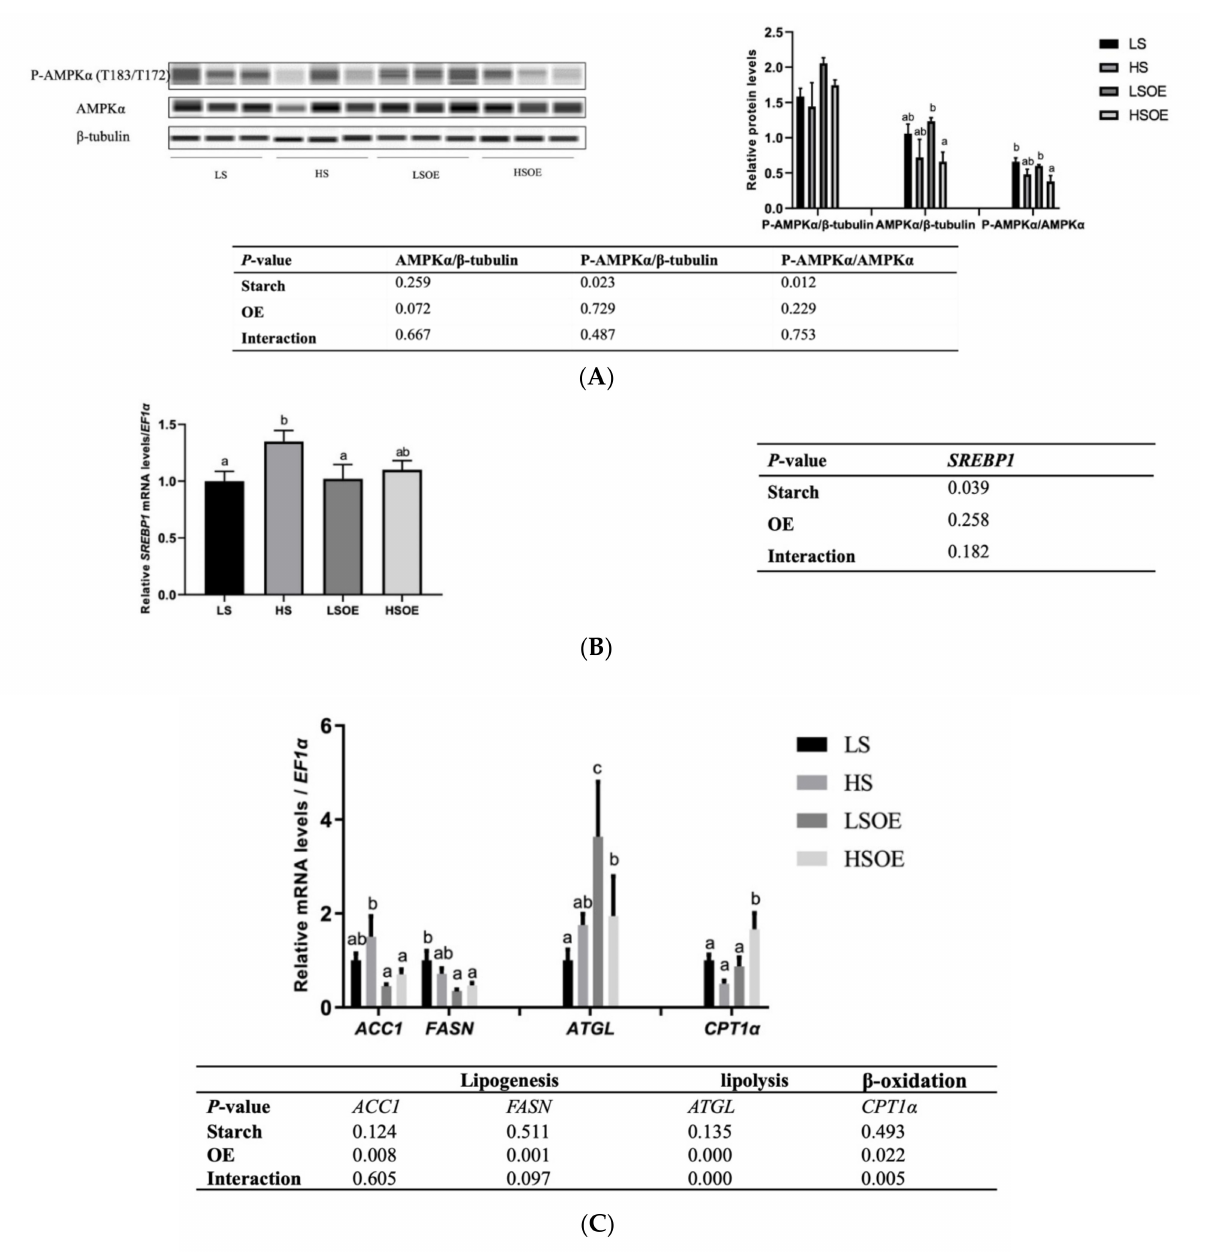
Figure 3. Effects of different diets on the hepatic lipid metabolism of largemouth bass. ( A ) Western blot of P-AMPK and AMPK in the liver (n = 3). ( B ) Transcriptional levels of SREBP1 (n = 8). ( C ) Transcriptional levels of hepatic FA synthesis ( ACC1 and FASN ), TG hydrolysis ( ATGL ), and β -oxidation ( CPT1 α ) related genes (n = 8). Both one-way ANOVA and two-way ANOVA statistics were analyzed. Differences were regarded as significant when p < 0.05 (n = 8). Values marked with “a, b and c” are significantly different according to one-way